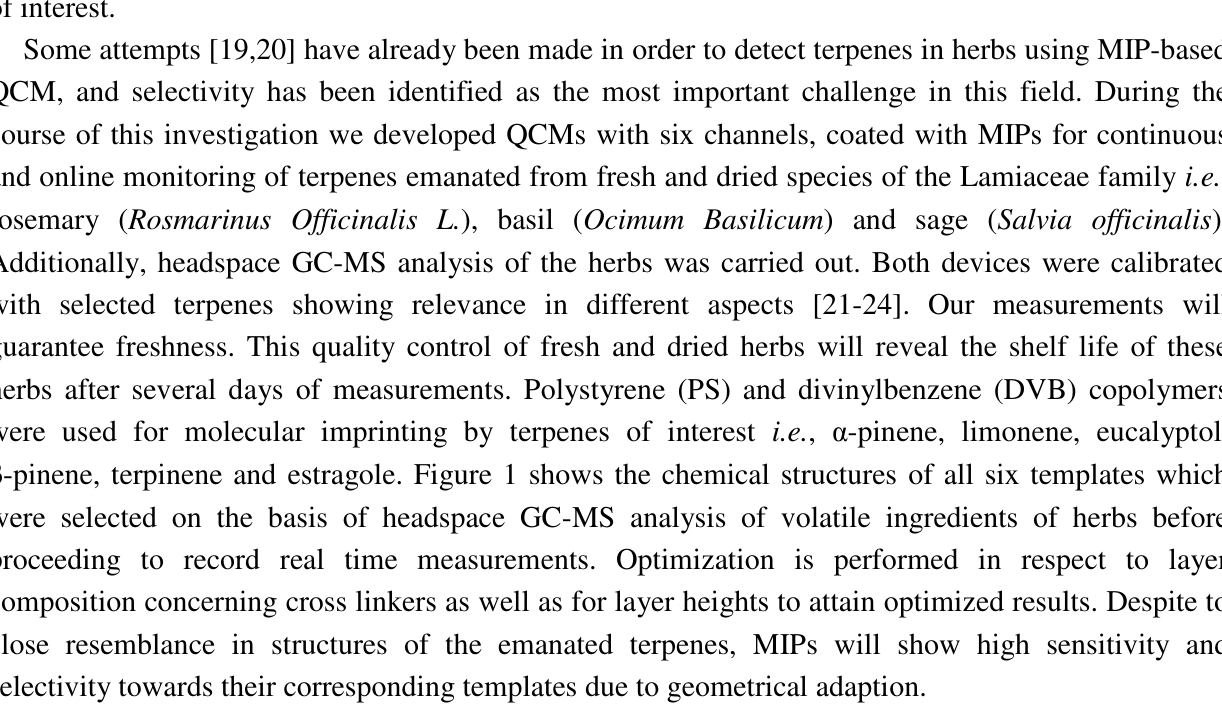
Figure 1. Structures of terpenes used for molecular imprinting and chemical sensing.